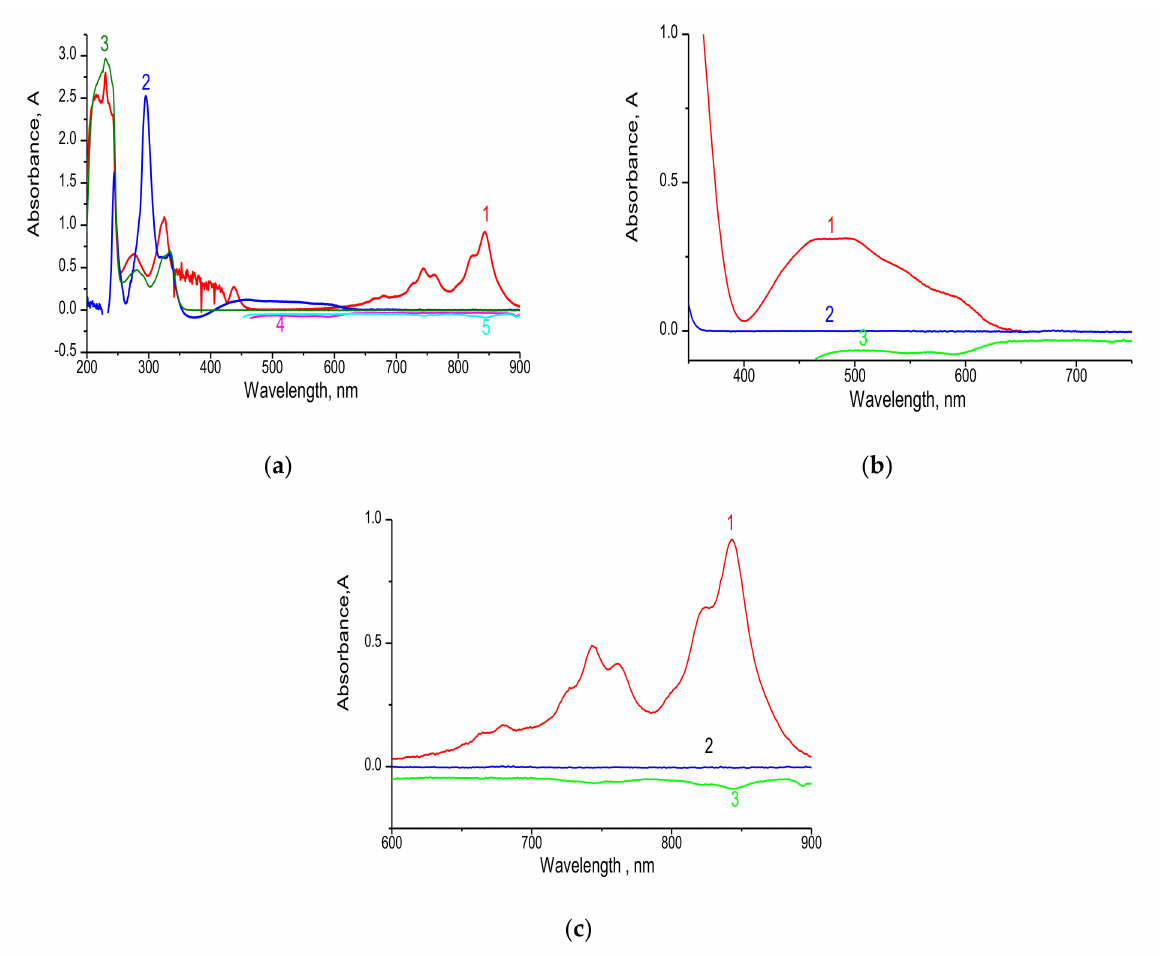
Figure 2. ( a ) Absorbance spectrum of (1) Q-TCNQ (2) 400 ppm Q-DDQ and (3) 400 ppm Q, (4) DDQ blank and (5) TCNQ versus blank. ( b ) Absorption spectrum of (1) 400 ppm of Q-DDQ complex, (2) 400 ppm of donor (quinine), and (3) DDQ versus Blank. ( c ) Absorption spectrum of (1) 400 ppm of Q-TCNQ complex, (2) 400 ppm of donor (quinine) and (3) TCNQ versus Blank.